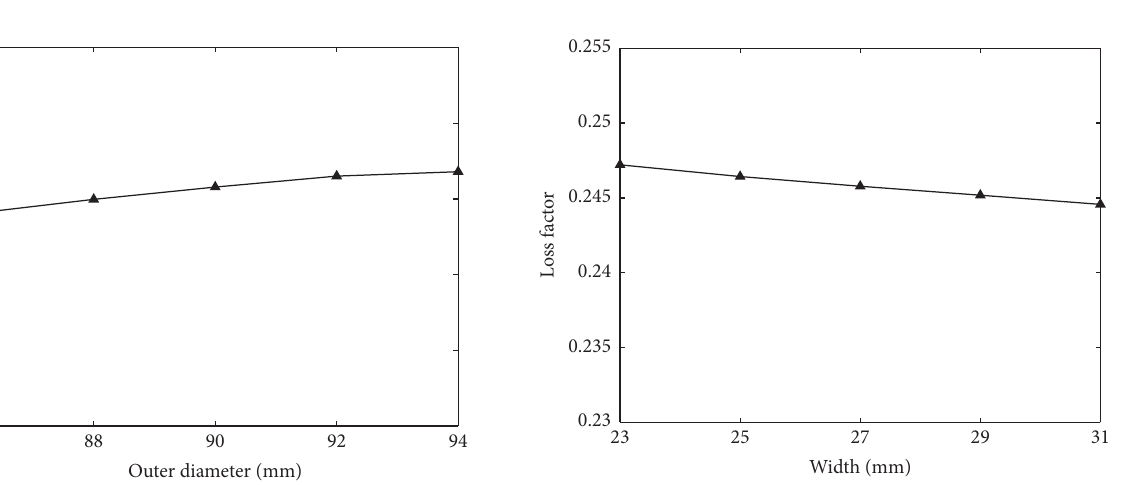
Figure 20: Influence of the variations in outer damping ring di- ameter of on loss factor.